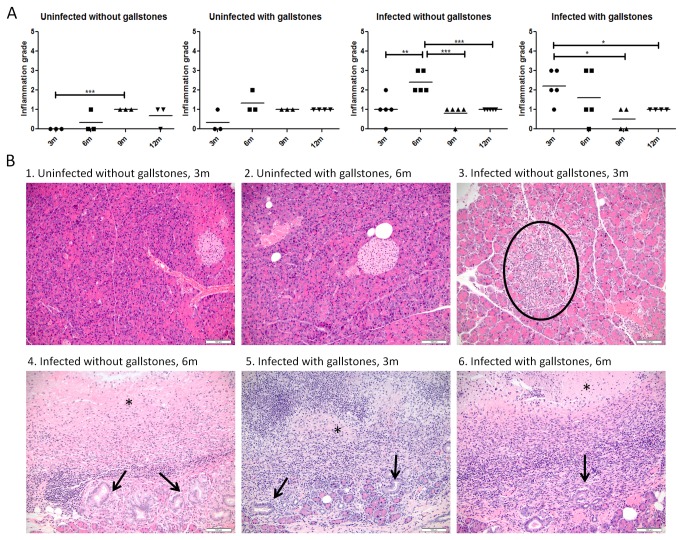
Chronic pancreatitis is exacerbated in infected mice at 3 and 6 months post-infection.(A) Inflammation grades in the pancreas at all time points post-infection (± bacteria, ± gallstones). Means of each time point values were compared by a Student’s t test (*, p<0.05; **, p<0.01 ***, p<0.001). (B) Representative HE images of each group at 3 and 6 months post-infection. Inflammation scores are as follows: B1 (0); B2 (1); B3 (2); B4, B5 and B6 (3). Inflammatory cells composed of scattered neutrophils, lymphocytes and plasma cells were occasionally distributed within the interstitium of the exocrine pancreas between acini (circle). In more severe cases, inflammation was centered upon and typically obliterated large ducts (B4-B6) and was characterized by necrotic debris (*) centrally, and lymphoplasmacytic aggregates and mucous metaplasia (black arrows) peripherally. 20x.